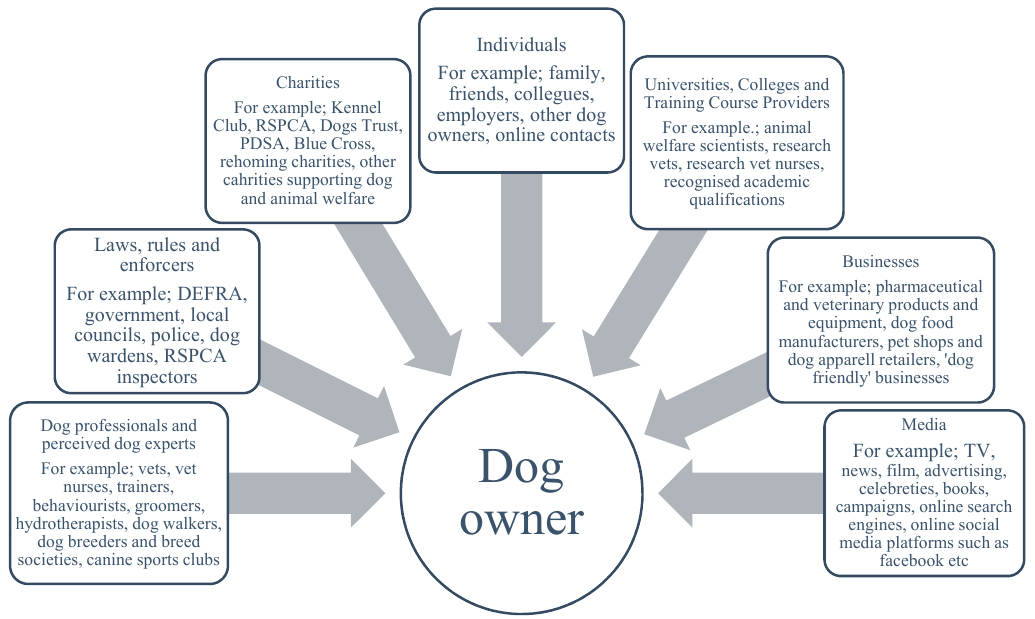
Figure 2. Who, what, or where are the current dog owner educators, teachers, instructors, authorities, communicators, or influencers on dog owners and their dog ownership practices in the UK in 2019?